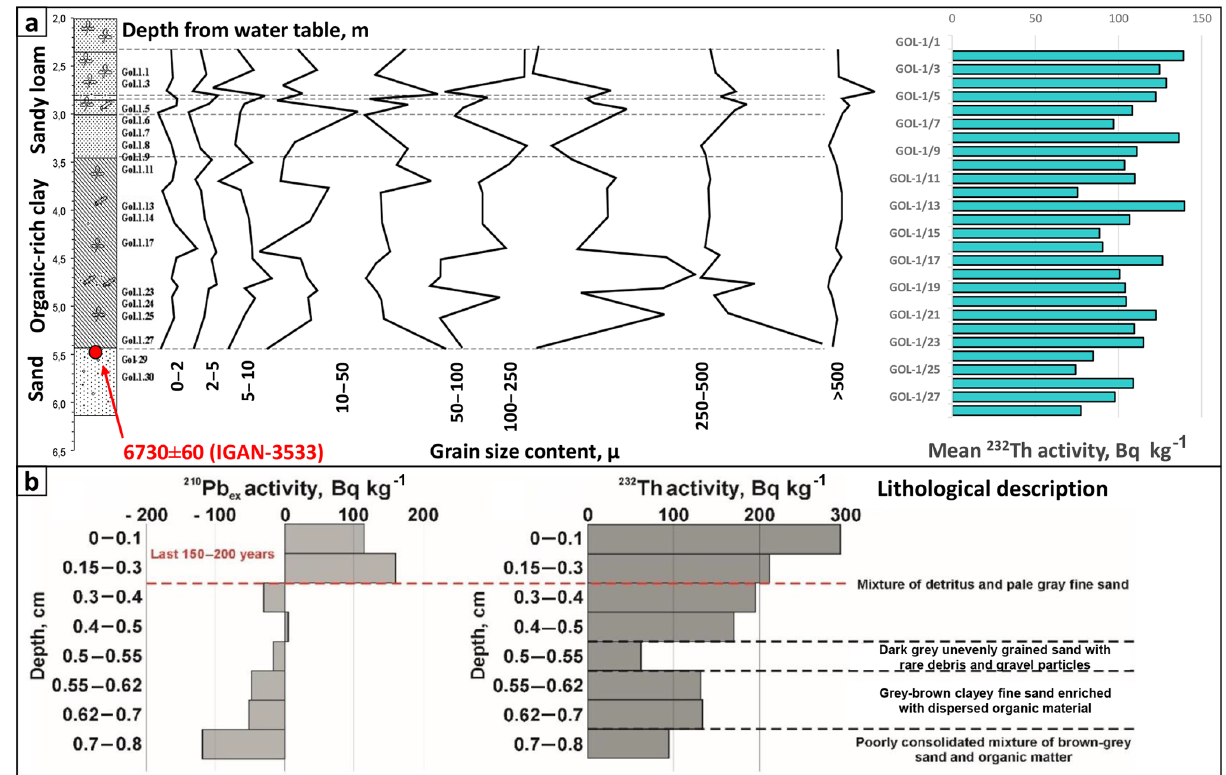
Figure 4. Redistribution of 232 Th radionuclides in lacustrine sediments of the Goltsovoye Lake (a) . Depth distribution of 210 Pb ex and 232 Th in the upper part of the profile (b)